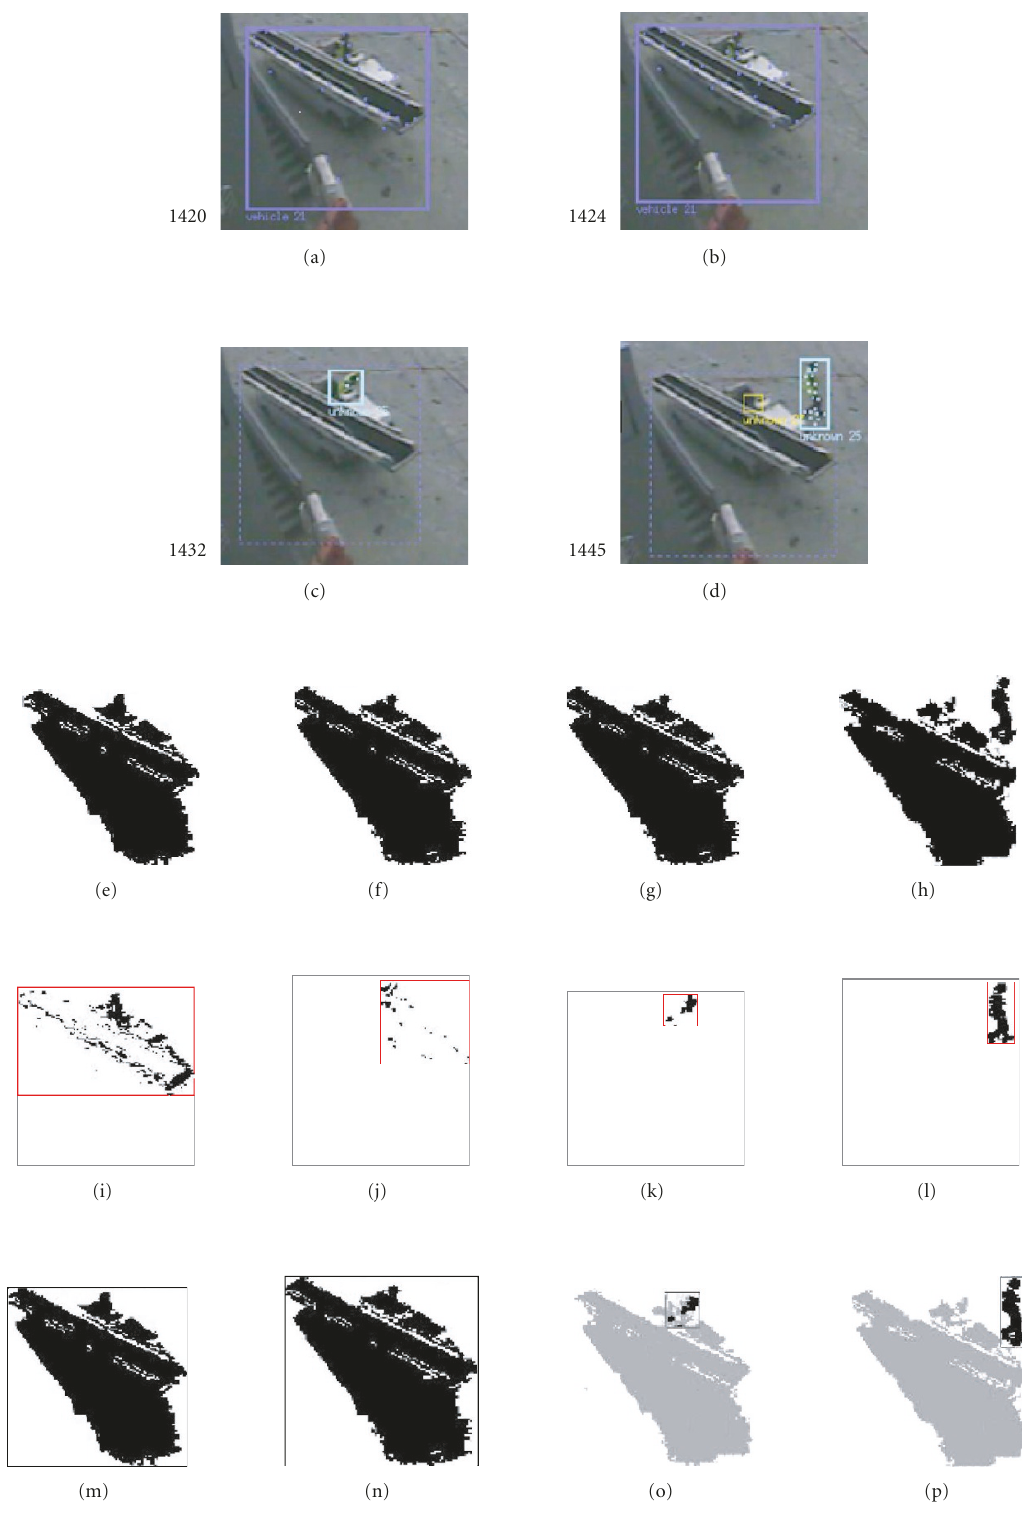
Figure 6: (a)–(d) Several frames showing a conveyor belt vehicle coming to rest, while its driver remains in motion and the vehicle exits; (e)–(h) show the pixels labelled as foreground by the motion detector (in black); (i)–(l) the foreground pixels detected as nonstationary are shown in black; (m)–(p) the object’s part in motion is shown in black, while the stationary part of the object is shown in grey. In (o), the driver is separated from the vehicle object, but due to problems with the update of the background model, it can be seen that a temporary ghost is created in